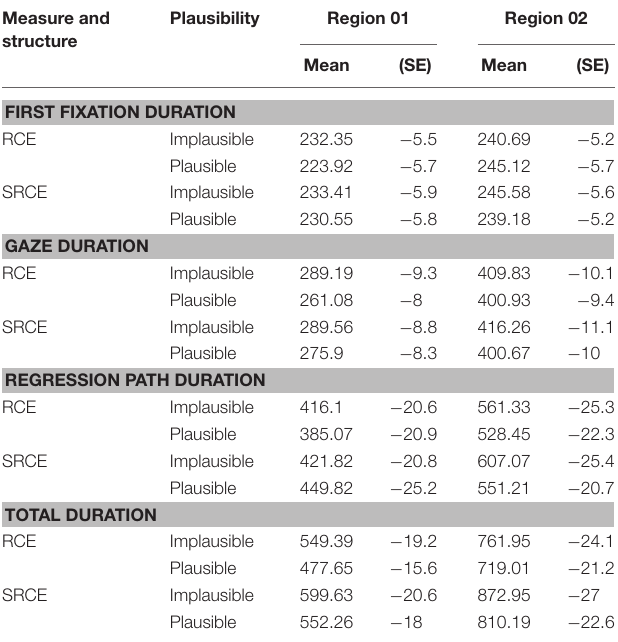
TABLE 6 | Experiment 2 mean and residualized fixation durations for Structure and Plausibility. Measure and